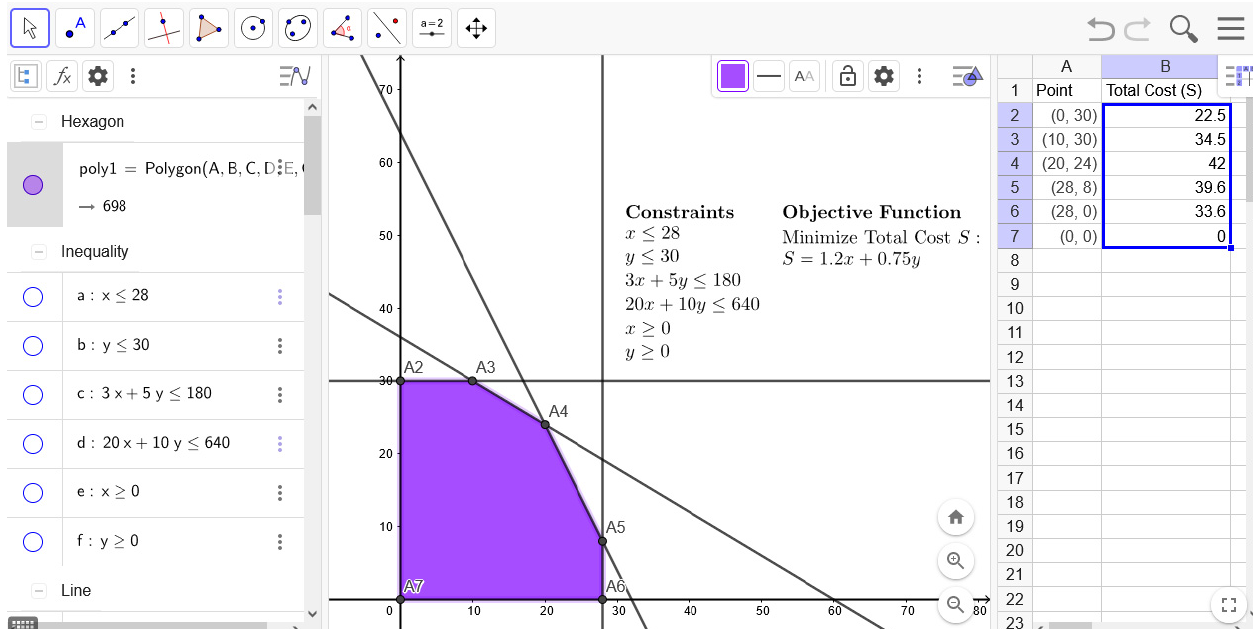
Figure 4. Solving a linear programming problem. Using the available linear graphing tools and the spreadsheet tool facilitates finding the feasible set, associated vertices, and optimal solution.